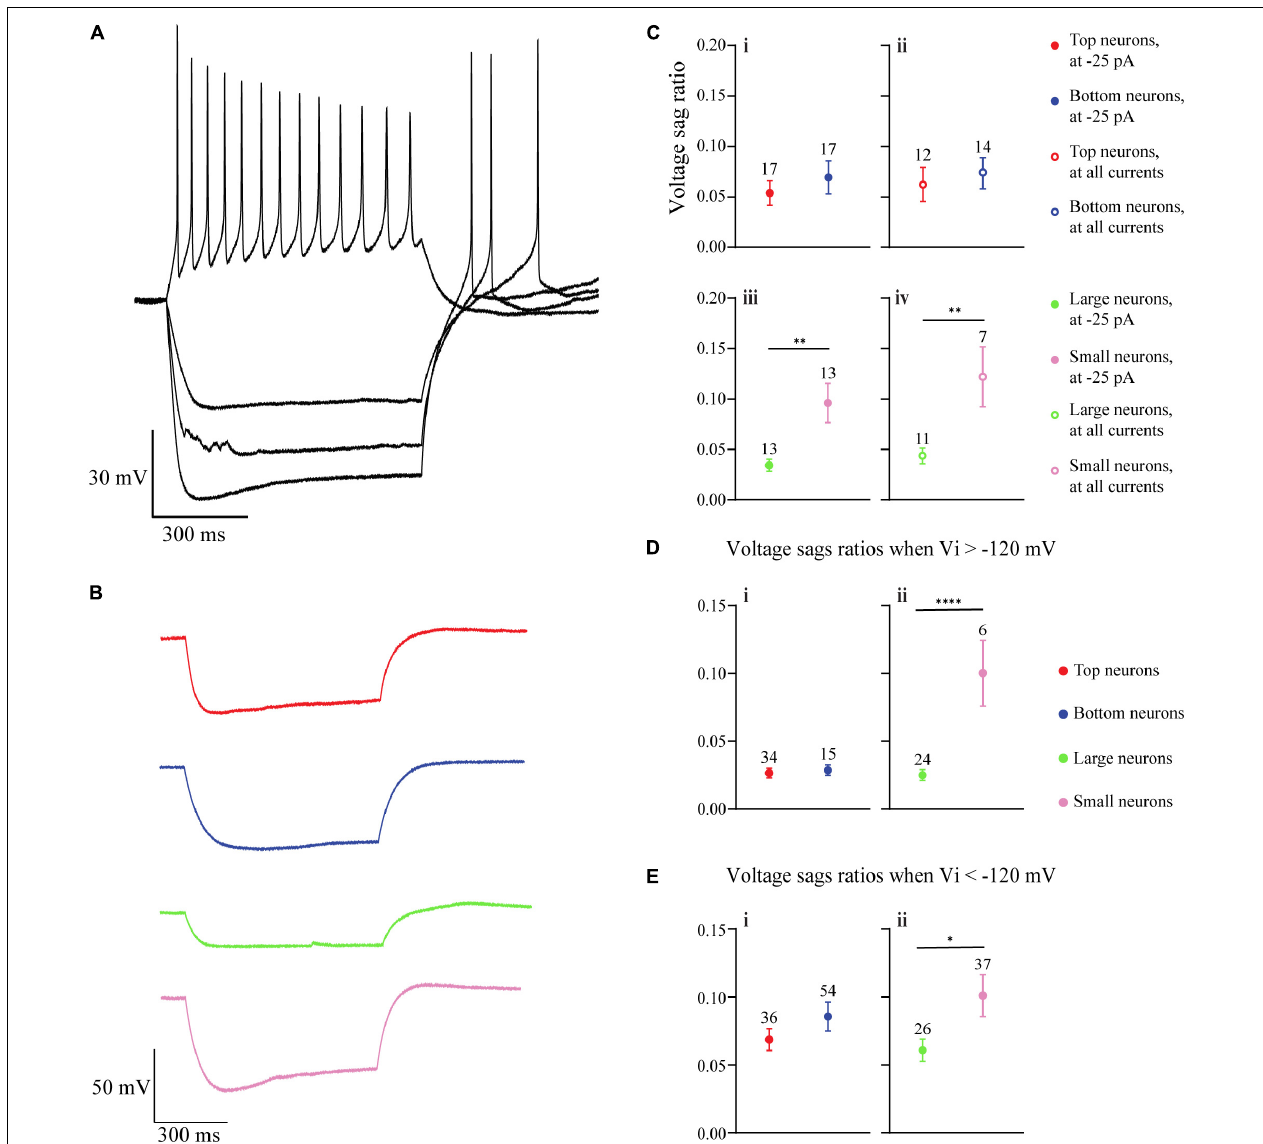
FIGURE 5 | The hyperpolarization-activated, non-specific cation I H in OB DA neurons is identified by upward voltage sags during hyperpolarization, after hyperpolarization depolarization, and (sometimes) an action potential following hyperpolarizing stimuli. (A) An example of a DA neuron showcasing these three properties of I H during three hyperpolarizing current (–25, –50, and –75 pA) injections. (B) Representative hyperpolarizing traces of each of the four groups of DA neurons from this study (red = Top, blue = Bottom, green = Large, pink = Small). All traces are scaled to the scale on the bottom left of the figure. (C) A comparison of voltage sag ratios of DA neurons based on their glomerular localization and neuronal area. There was no significant difference between DA neurons based on their glomerular localization, either when the neurons received a –25-pA stimulus (“at –25 pA,” n = 34, p = 0.4500, Ci ) or when receiving a combination of –25, –50, and –75 pA, or all three hyperpolarzing currents (“at all currents,” n = 26, p = 0.5904, Cii ). There were significant differences between DA neurons based on the neuronal area, both when receiving only a –25-pA stimulus ( n = 26, p = 0.0061**, Ciii ) and when receiving the combination of hyperpolarizing currents ( n = 18, p = 0.0067**, Civ ). (D) Voltage sag ratios of DA neurons were compared at starting membrane potentials positive to –120 mV. There was no significant difference between neurons based on glomerular localization ( n = 49 sags, p = 0.6784, Di ), but Small DA neurons had a significantly greater voltage sag ratio than Large neurons ( n = 30 sags, p < 0.0001****, Dii ). (E). Voltage sag ratios of DA neurons were also compared at membrane potentials negative to –120 mV. Again, there was no significant difference between neurons based on glomerular localization ( n = 90 sags, p = 0.2576, Ei ), but Small DA neurons had a significantly greater voltage sag ratio than Large neurons ( n = 63 sags, p = 0.0432*, Eii ). All data represented as mean ± SEM.